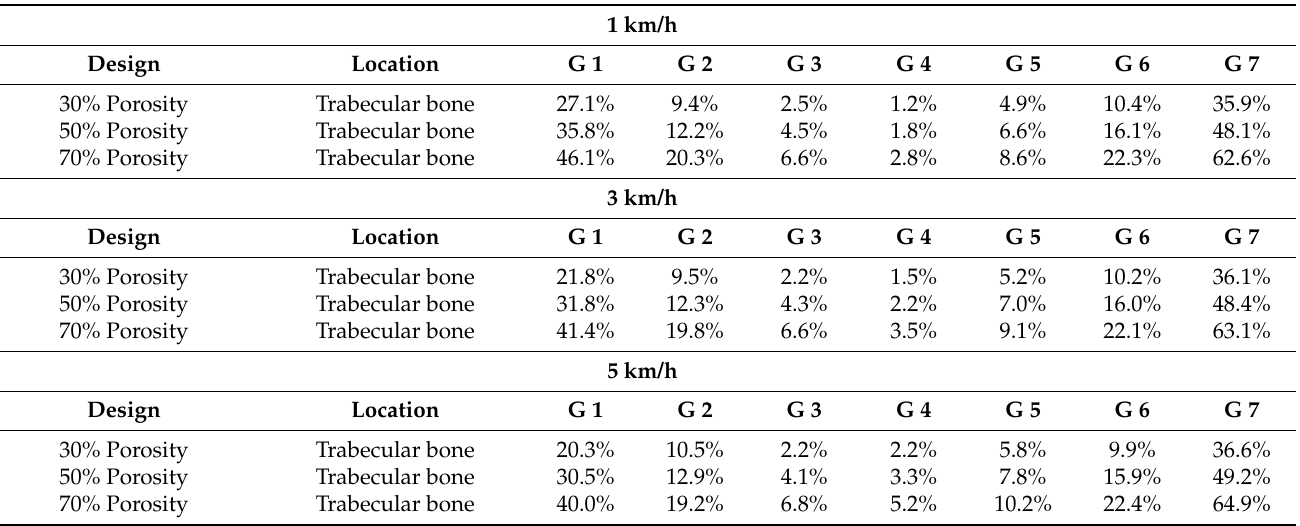
Table 4. Stress transfer percentages of the functionally graded porous stems in comparison to the bulk Ti (reduction in stress